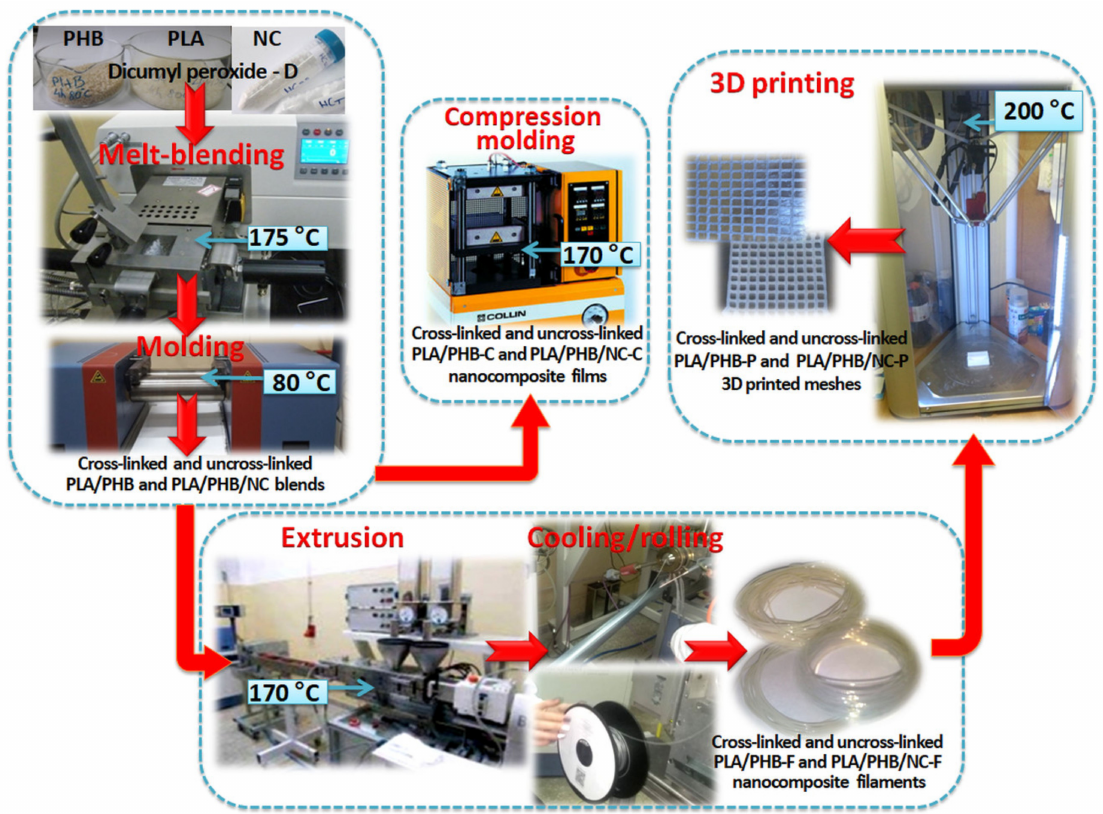
Figure 1. Schematic representation of PLA / PHB blends and nanocomposites preparation and processing of films, filaments, and 3D-printed